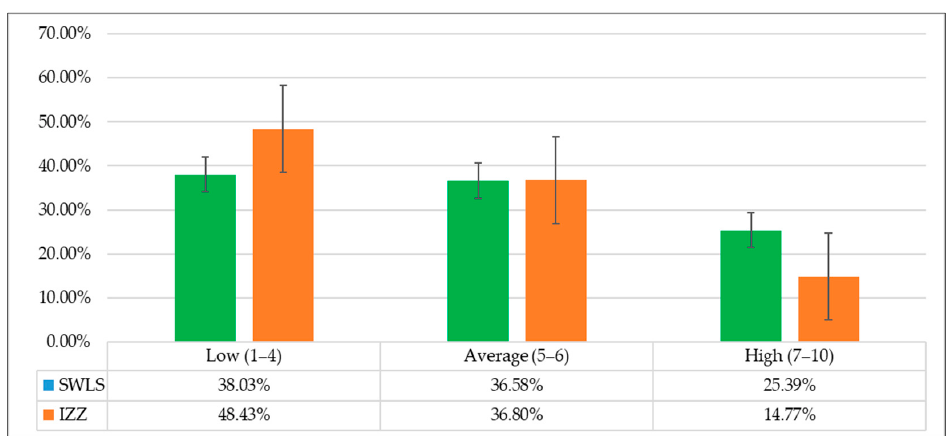
Figure 1. Result distribution for a sense of satisfaction with life and health behaviours on the sten scale. Abbreviations: SWLS—Satisfaction With Life Scale, IZZ—Health Behaviour Inventory.